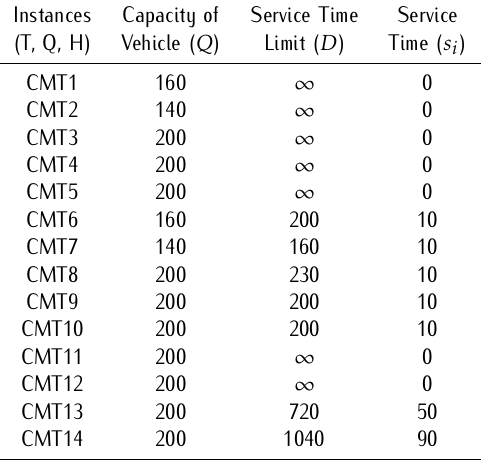
Table 3. Parameters of CMT